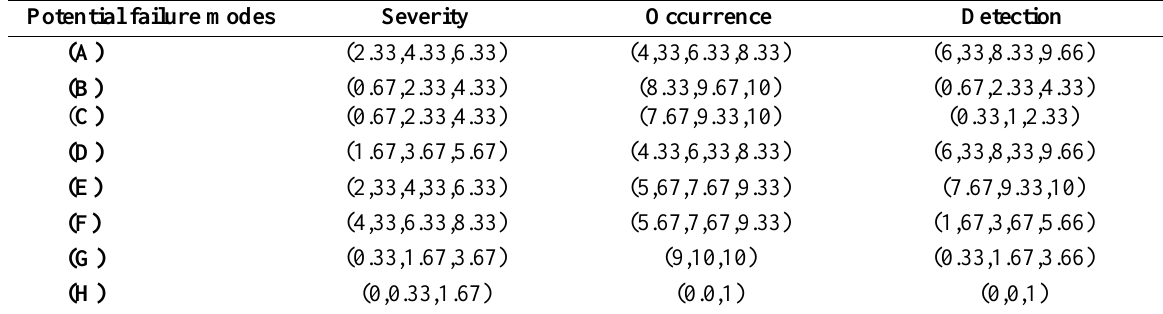
Table 7. Aggregated matrix